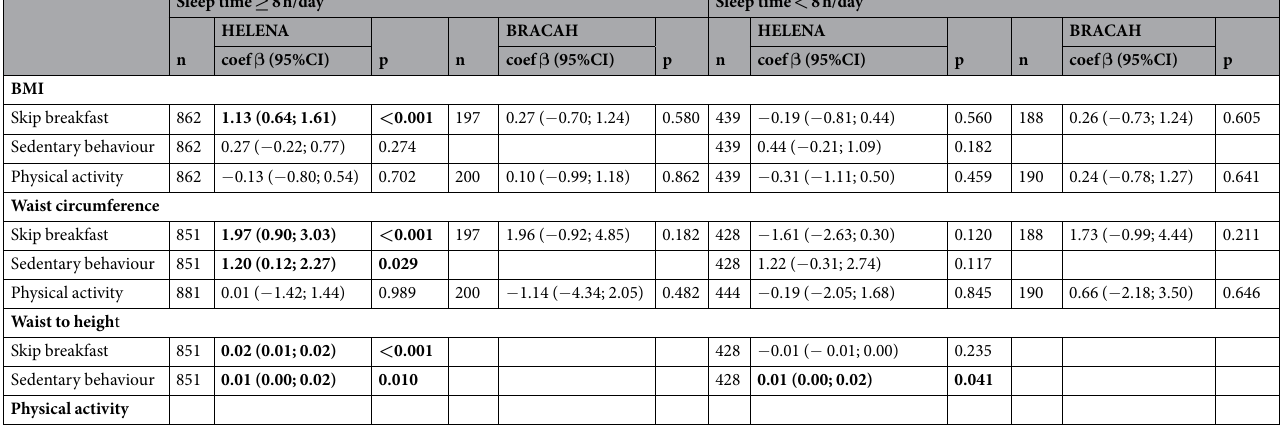
Table 3. Adjusted * association between EBRBs and general and abdominal obesity stratified by sleep time among adolescents’ girls studied from HELENA-CSS and BRACAH study Adjusted by potential confounders: center (only in HELENA-CSS), age and education mother. Significant associations are in bold. EBRBs: energy balance-related behaviours, BMI: body mass index, HELENA-CSS: Healthy Lifestyle in Europe by Nutrition in Adolescence cross-sectional study, BRACAH study: Brazilian Cardiovascular Adolescent Health study, CI: confidence interval, coef β : beta